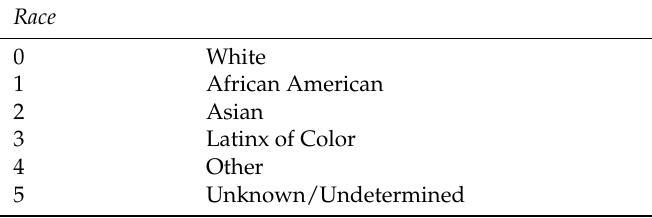
Table A1. Coding